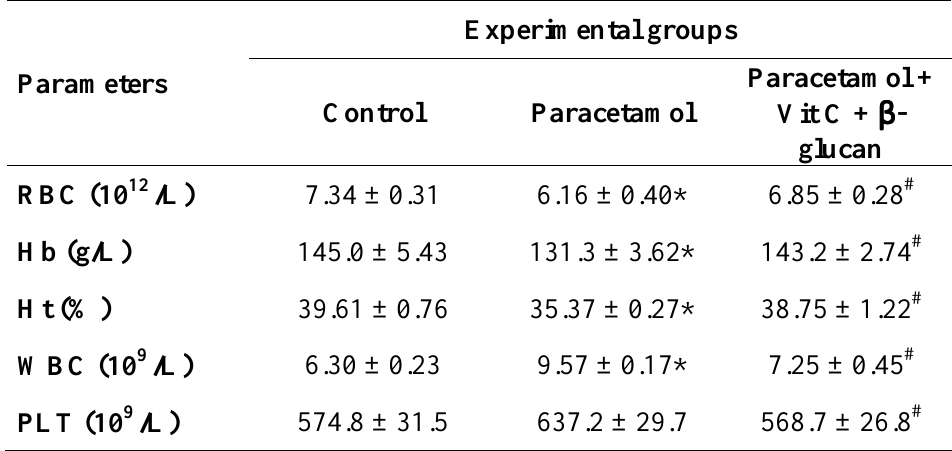
Vit C: vitamin C; b -glucan: 1,3-1,6 b -D-glucan; RBC: red blood